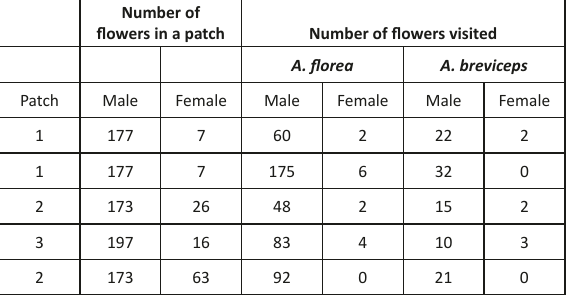
Table 1. Number of A. florea and B. breviceps visits to male and female flowers of B. satrapis. Number of flowers in a patch Number of flowers visited